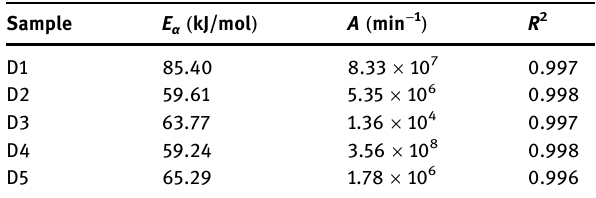
Table 4: Combustion kinetic parameters of di ff erent samples